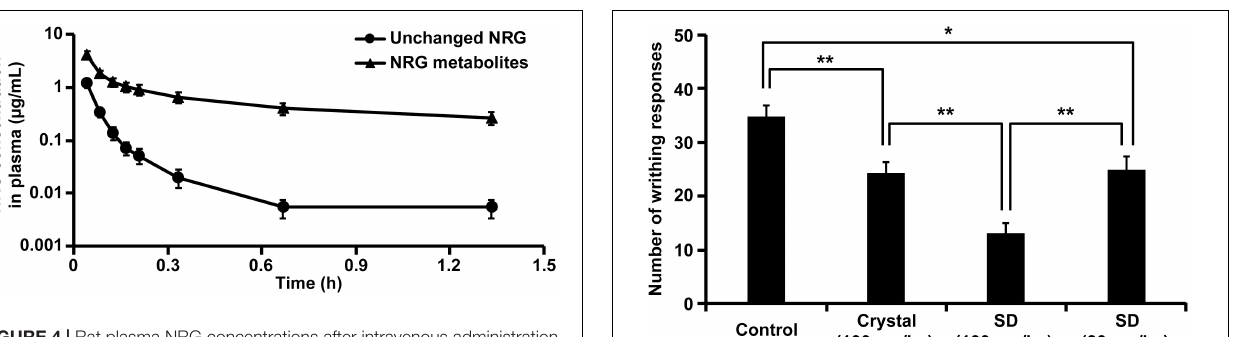
FIGURE 4 | Rat plasma NRG concentrations after intravenous administration of unchanged NRG and NRG metabolites. Serum containing 34.8 µ g/mL unchanged NRG or 134.5 µ g/mL NRG metabolites was administered to rats at 500 µ L (means ± SE, n = 4). TABLE 2 | Pharmacokinetic profiles of intravenously administered unchanged NRG and NRG metabolites in rats. Pharmacokinetic parameter